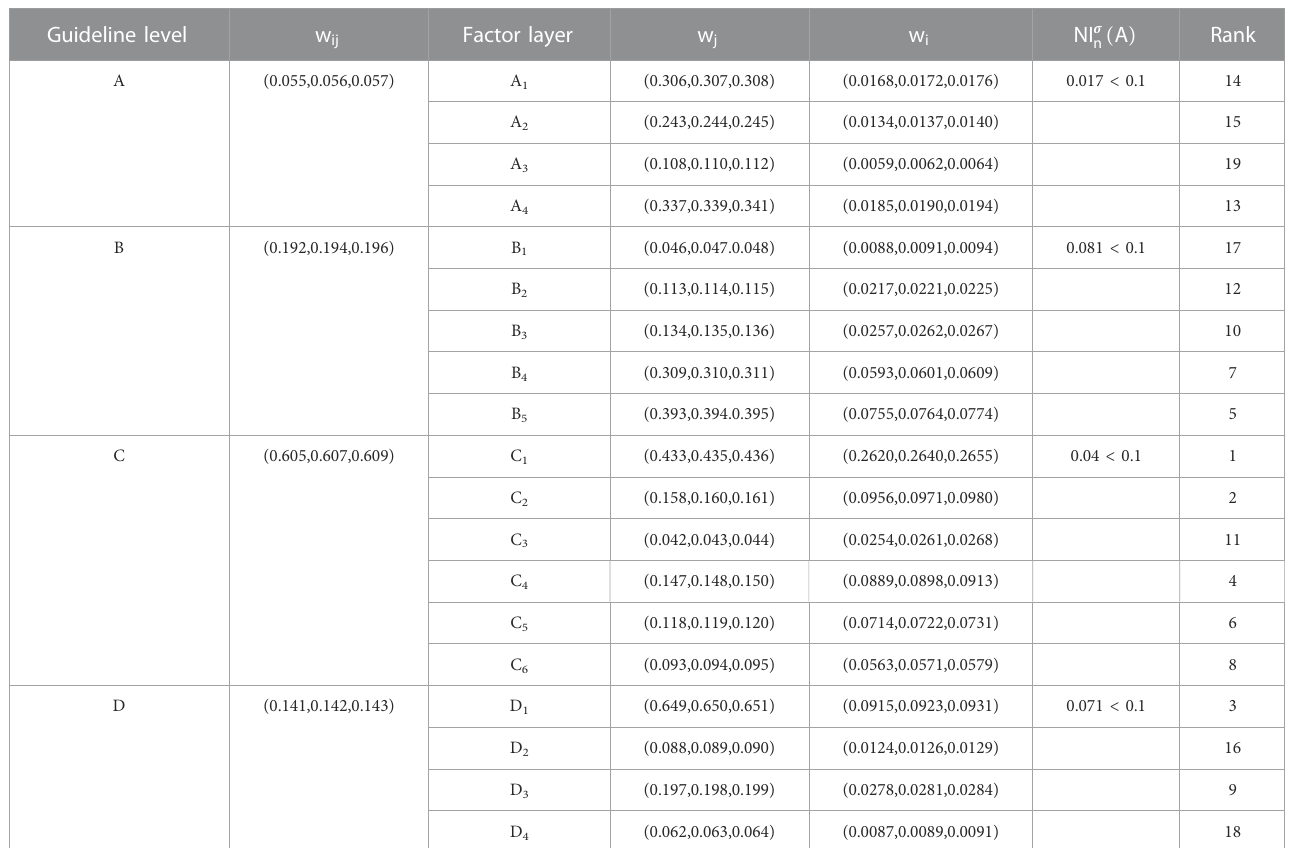
TABLE 14 Standard weight and total ranking of target layer (MCS-AHP). Guideline level